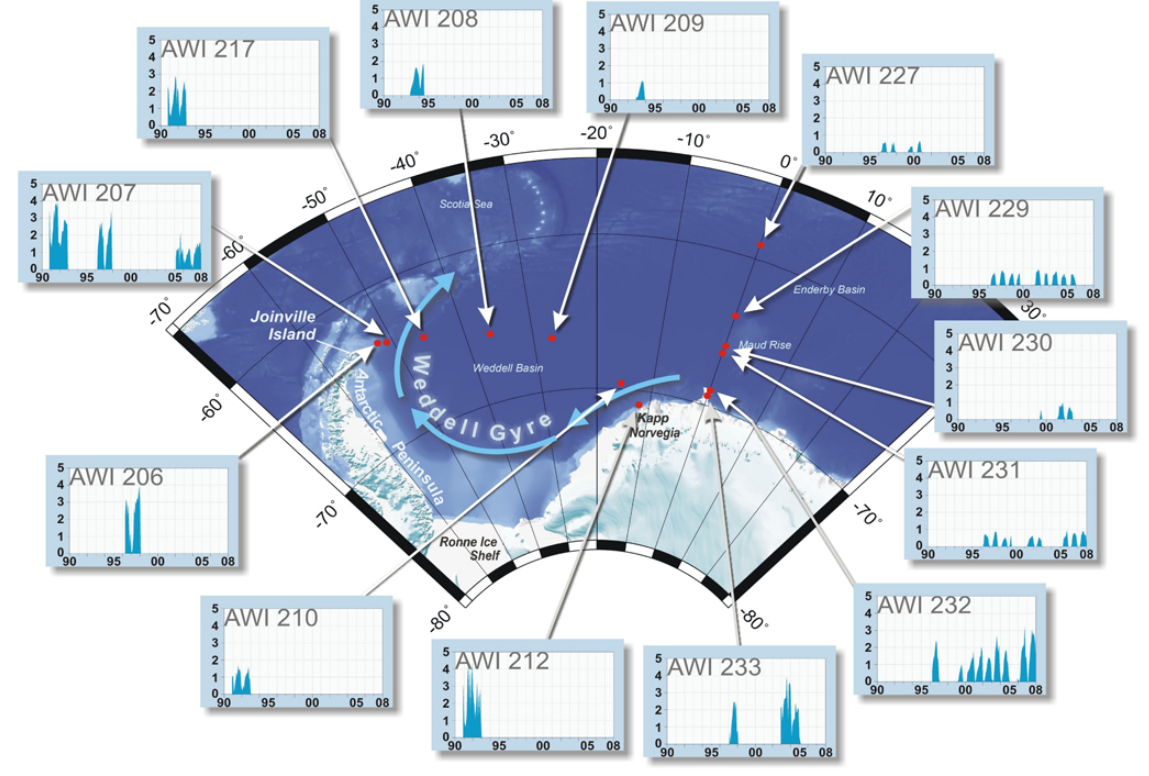
Figure 2. The AWI ULS array in the Atlantic sector of the Southern Ocean. The diagrams show monthly mean values of sea ice draft from 0 to 5m (y-axis), spanning the period from January 1990 to December